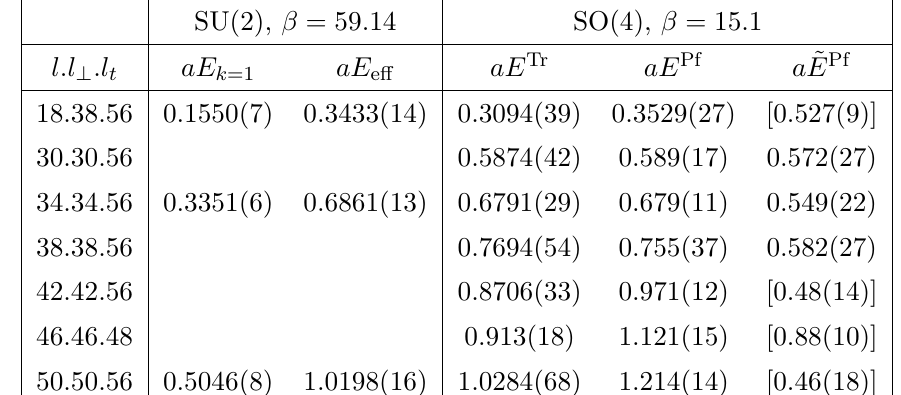
1 (cid:27) around mean of our asymptotic energy (cid:6)